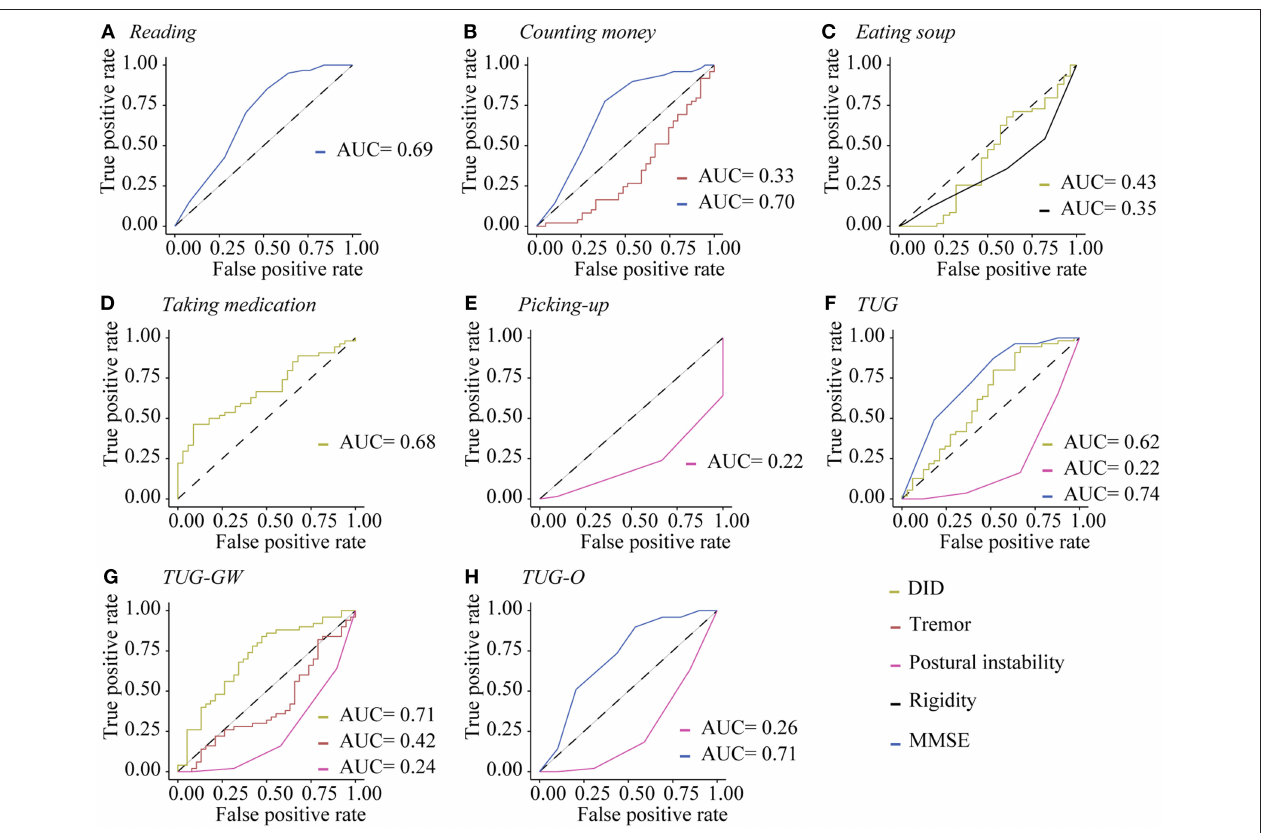
FIGURE 4 | ROC curves of significant factors impacting the performance of ADL. ROC curves of significant variables for (A) reading , (B) counting money , (C) eating soup , (D) taking medication, (E) picking-up an object , (F) TUG , (G) TUG-GW , (H) TUG-O . AUC, Area Under the